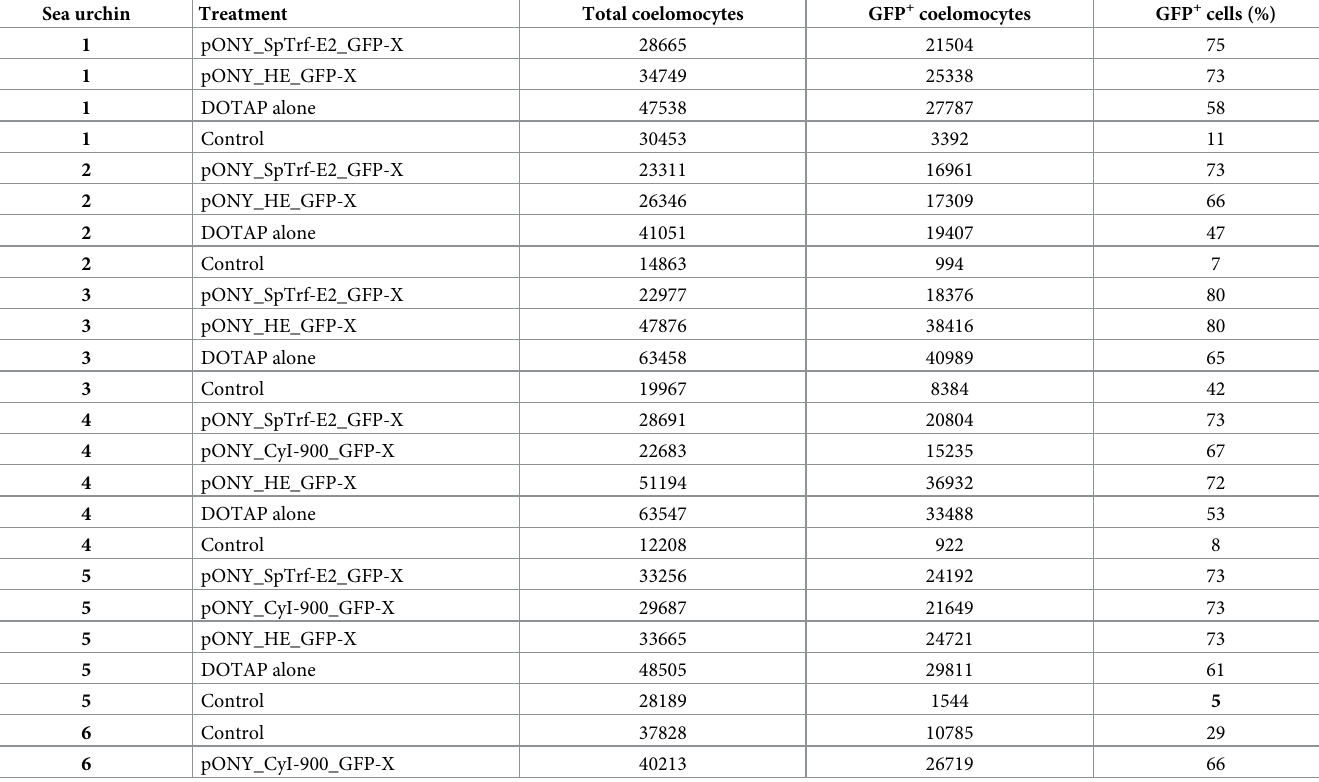
Table 2. The percentage of GFP + coelomocytes lipofected with GFP expression constructs is variable among samples 1 . Sea urchin